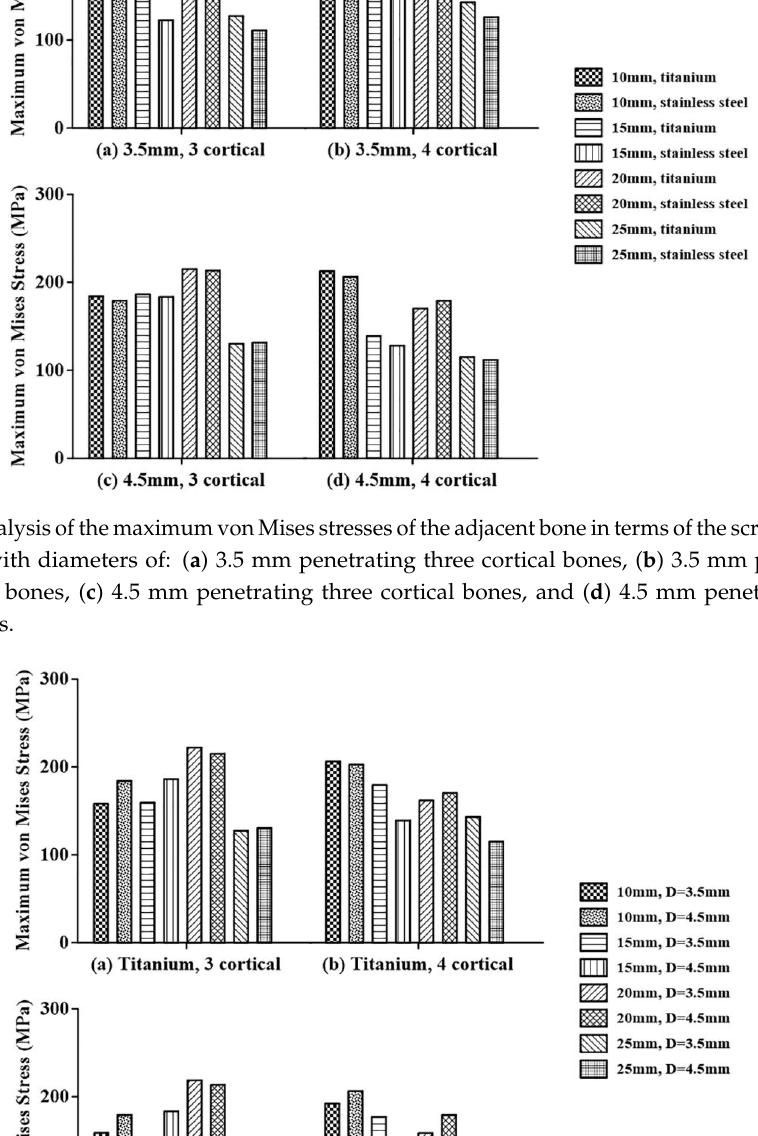
Figure 8. Analysis of the maximum von Mises stresses of the syndesmotic screw in terms of the number of penetrated cortical bones for: ( a ) titanium screw with a diameter of 3.5 mm, ( b ) titanium screw with a diameter of 4.5 mm, ( c ) stainless steel screw with a diameter of 3.5 mm, and ( d ) stainless steel screw with a diameter of 4.5 mm.